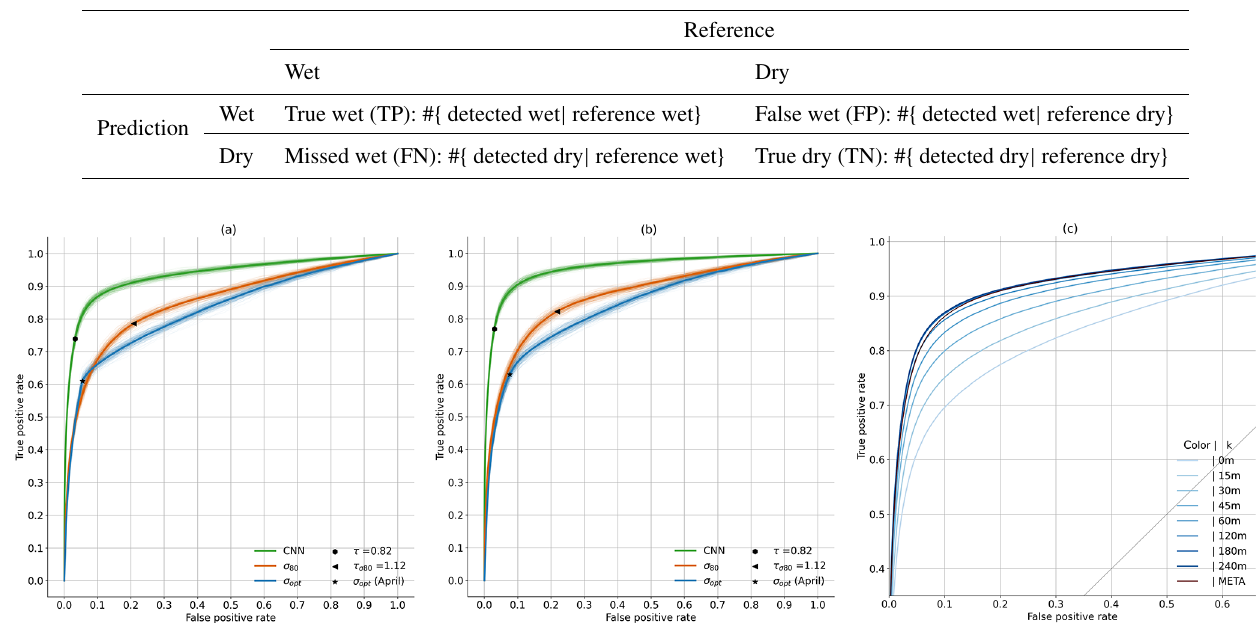
Table 1. Confusion matrix.